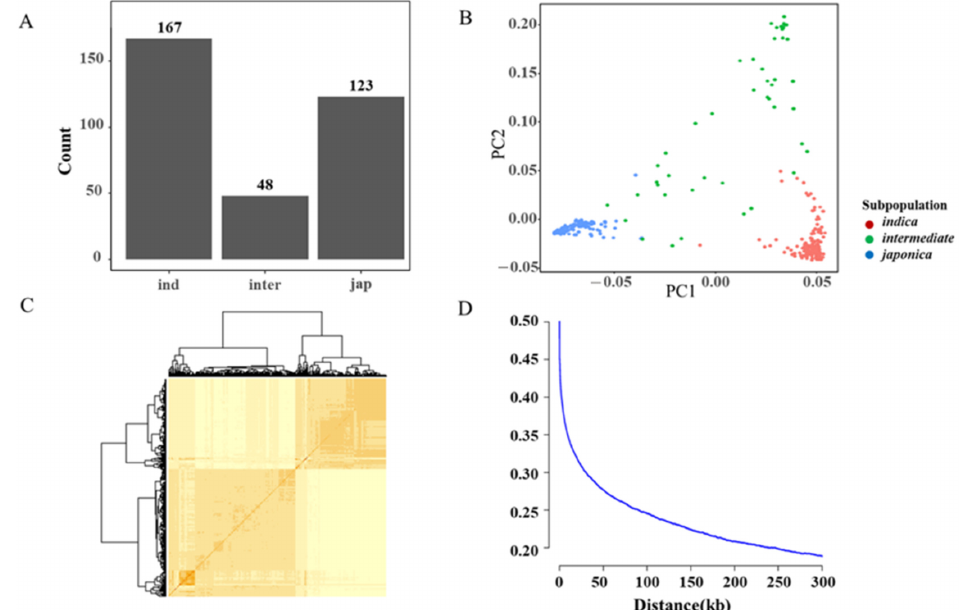
Figure 2. Population genetic analyses and polymorphic SNPs. ( A ) Distribution of 338 rice accessions. ( B ) Principal component analysis of the association panel analyzed by PLINK [25]. ( C ) Kinship analysis of the association panel. ( D ) LD decay calculated by PopLDdecay.